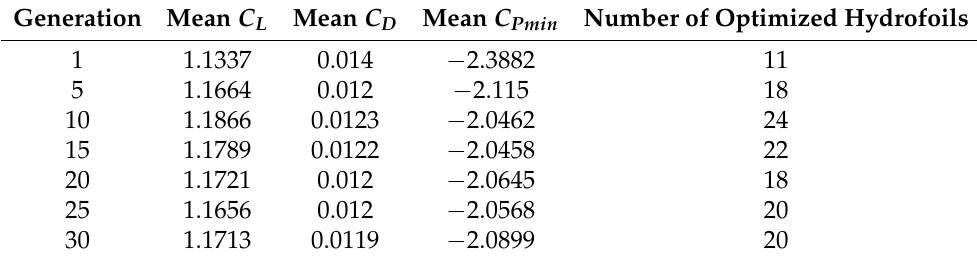
Table 1. Comparison of optimization results at different